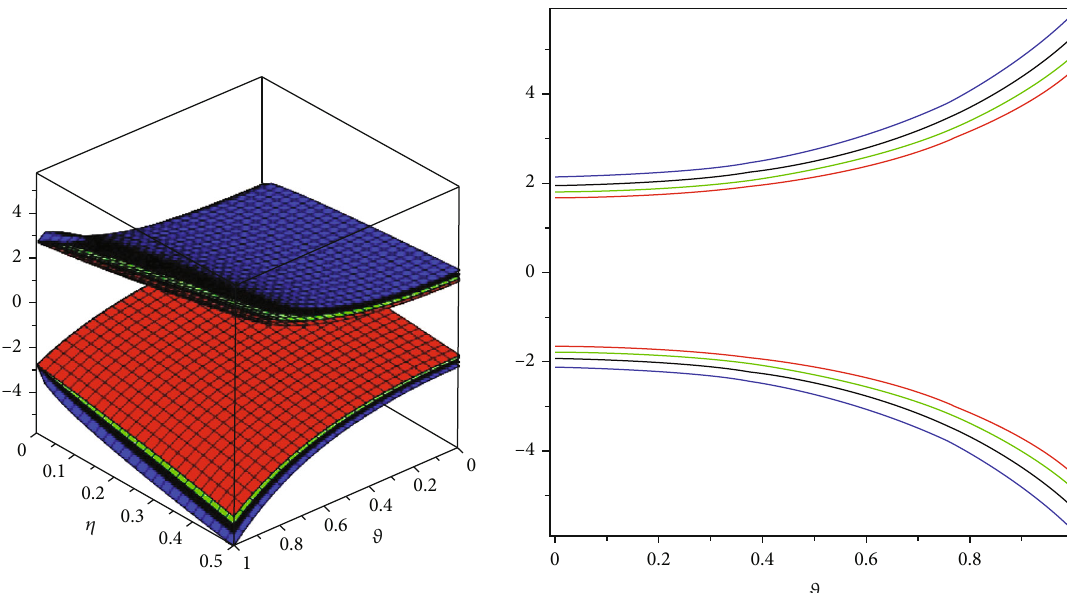
Figure 4: The various fractional order ϱ fi gures of upper and lower branches of analytical solution.